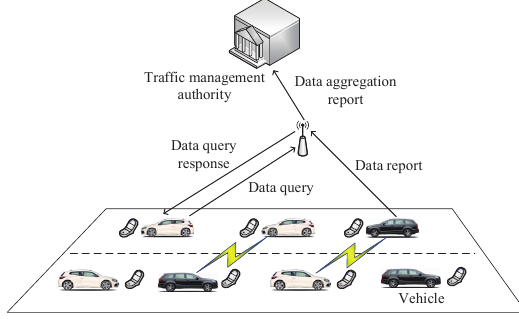
Figure 9. The architecture of the secure data sharing